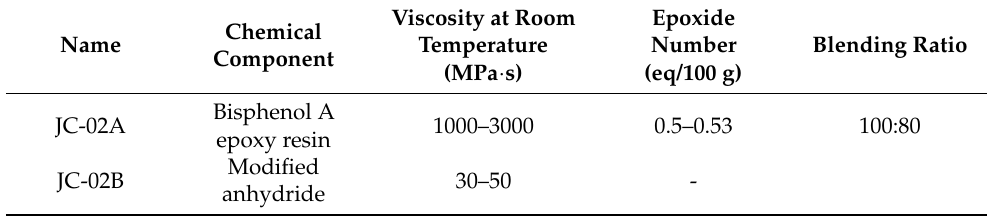
Table 1. Specifications of the epoxy matrix.